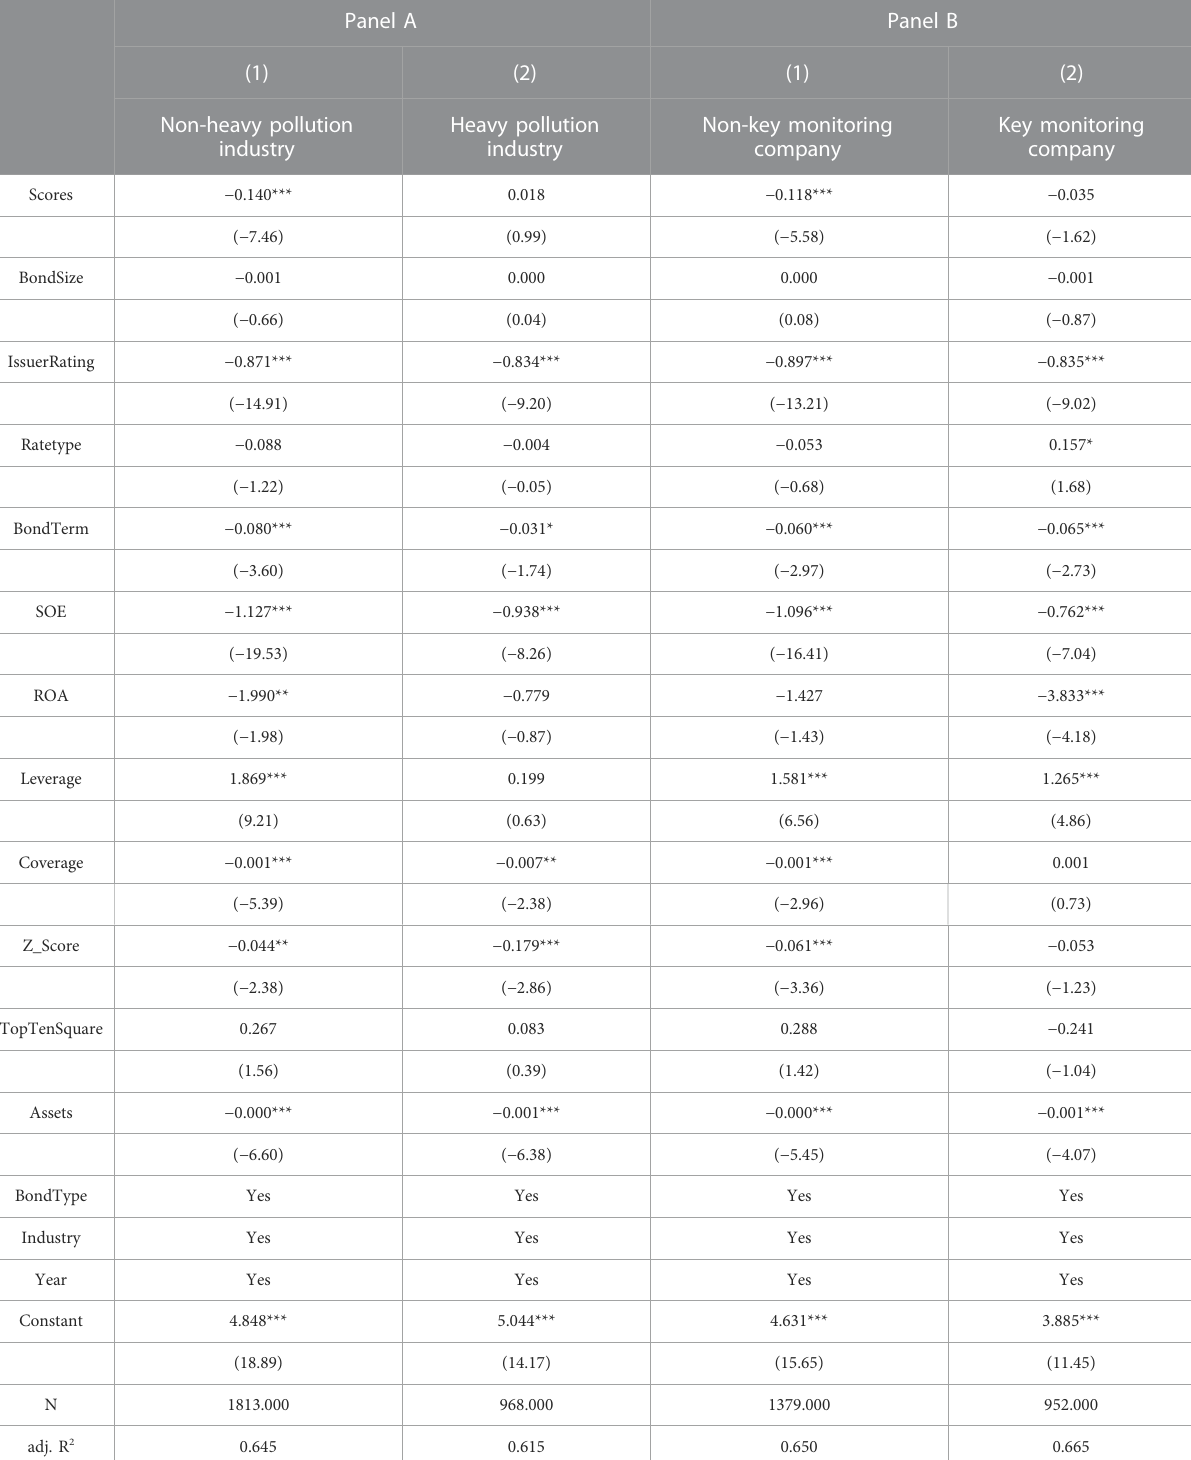
TABLE 8 Industry supervision and market monitoring